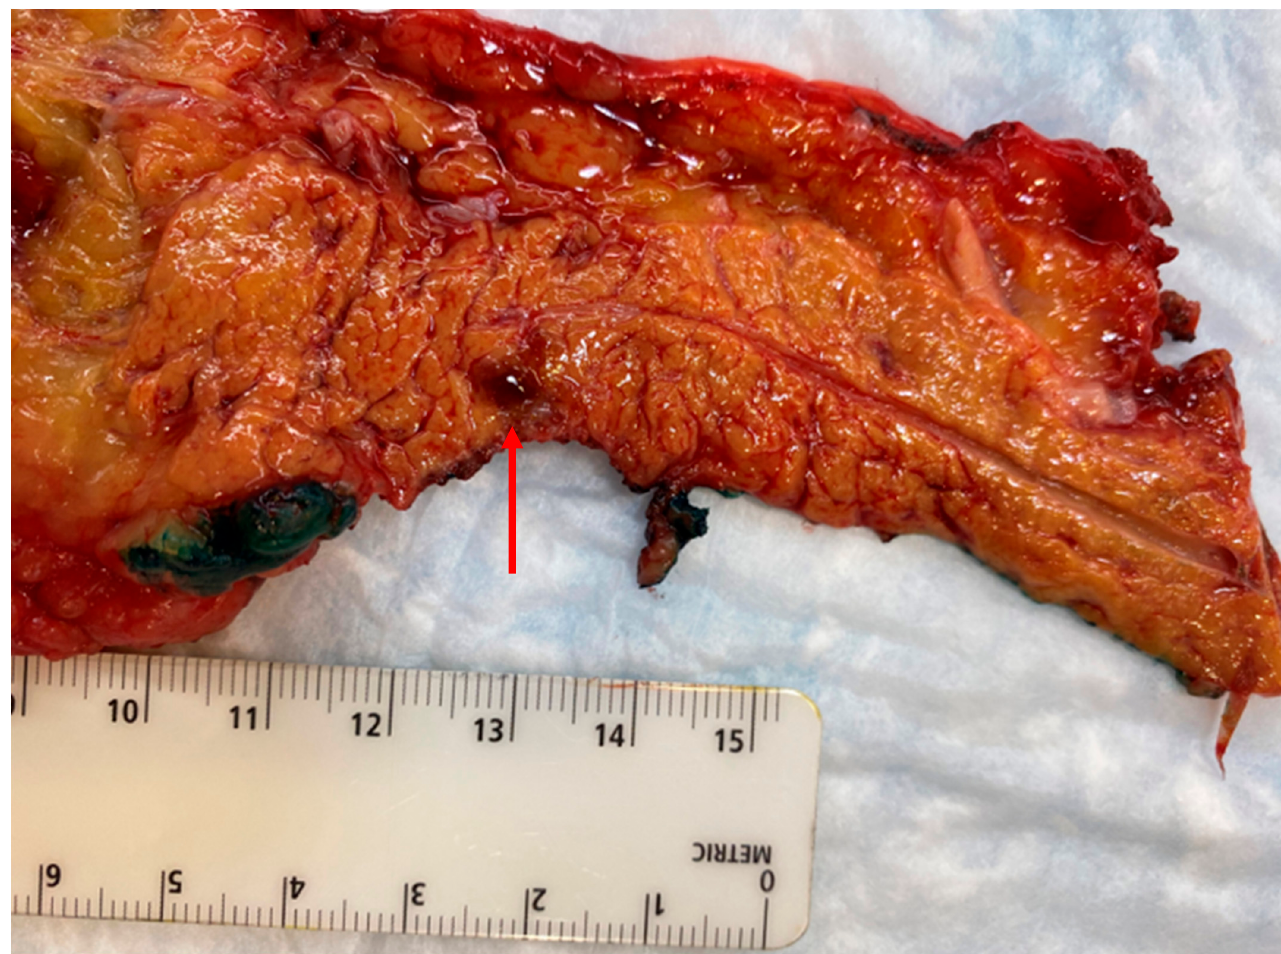
Figure 4. Distal pancreatectomy performed for a symptomatic, but diminutive (4 mm), insulinoma in the pancreatic tail that was not well visualized on cross-sectional imaging or endoscopic ultrasound, but localized with selective arterial calcium stimulation angiography.